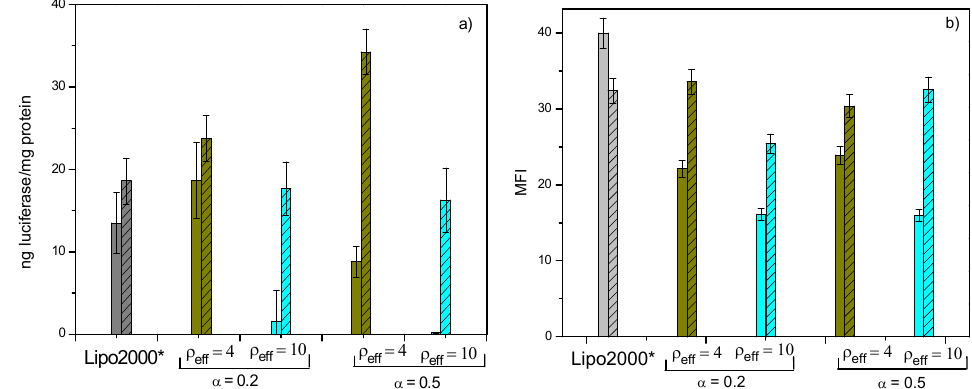
Figure 5. Transfection efficiency levels of C 3 (C 16 His) 2 /DOPE-pDNA lipoplexes in HeLa (solid bars) and COS-7 cells (dashed bars) at two molar fractions of the C 3 (C 16 His) 2 cationic lipid in the C 3 (C 16 His) 2 /DOPE mixed lipid ( α = 0.2 and 0.5): ( a ) in terms of ng of luciferase/mg of protein for plasmid pCMV-Luc, and ( b ) in terms of mean fluorescence intensity (MFI) for plasmid pEGFP-C3. The experiments were performed in the presence of 10% of fetal bovine serum (FBS). The green and blue bars correspond to effective charge ratios ρ eff = 4 and 10 of the lipoplex, respectively. Gray bar: Lipo2000* as the positive control. The data represent the mean ± SD of three wells and are representative of three independent experiments.